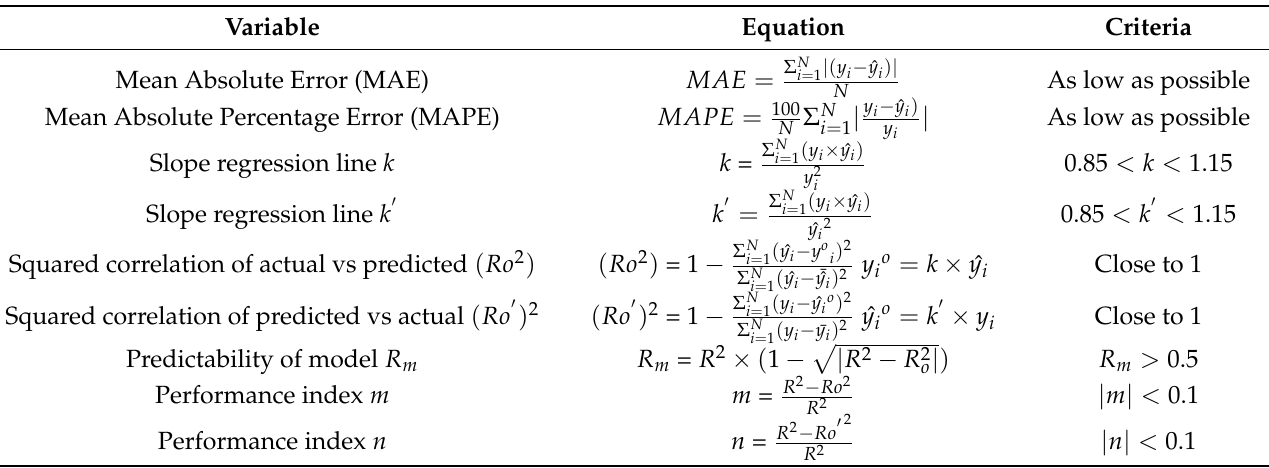
Table 1. Extra evaluation